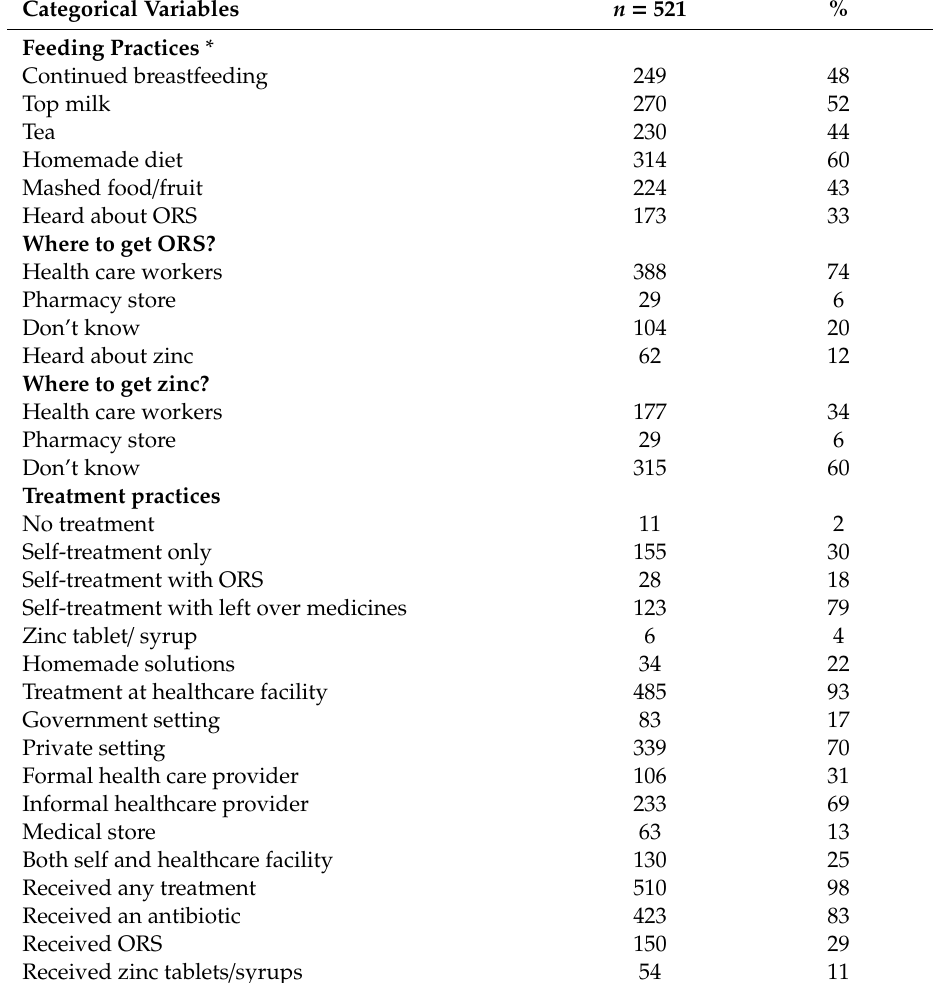
Table 3. Feeding practice and treatment received by 521 (33%) children out of the total 1571 children during the last episode of